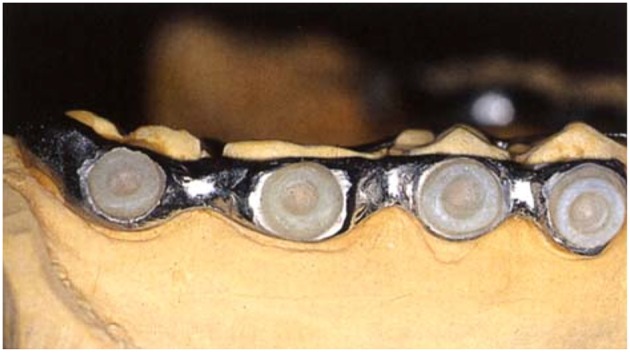
Metal Device (MD). Image by Simion et al. (1997) in Clinical Oral Implants Research.